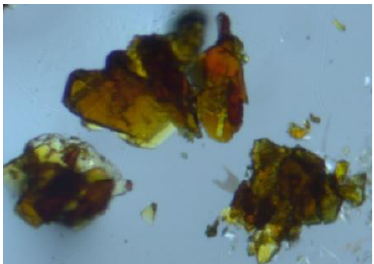
Figure 2. Photomicrograph of deposited crystals of [NpO 2 (NO 3 ) 2 ( L1 )] n . Molecular and crystal structures of this compound were determined by single crystal of NpO 2 (NO 3 ) 2 units connected by L1 linker molecules to form an infinite one-dimensional (1D) coordination polymer, [NpO 2 (NO 3 ) 2 ( L1 )] n , which should be formed through the fol- lowing reaction in the HNO 3 solution. n NpO 22+ + 2 n NO 3 − + n L1 = [NpO 2 (NO 3 ) 2 ( L1 )] n (cr),